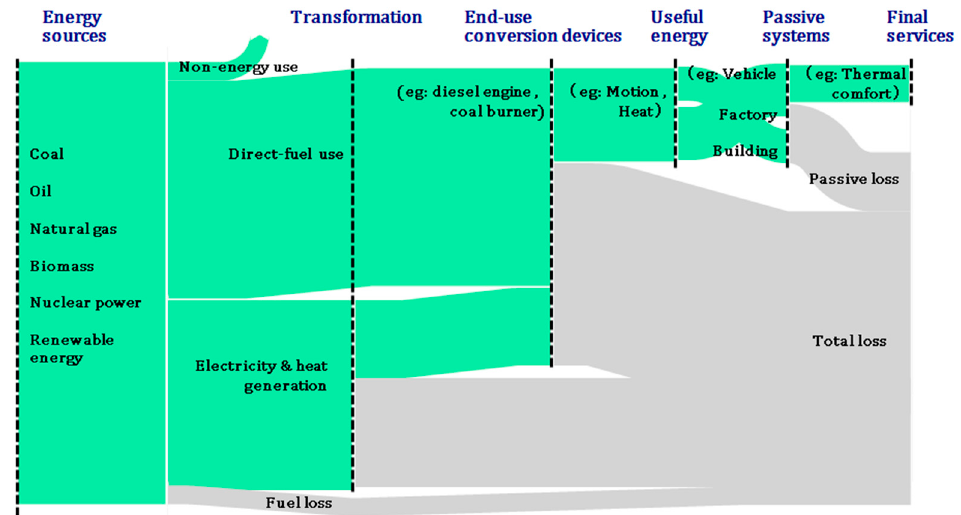
Figure 3. The stage division of the energy system.